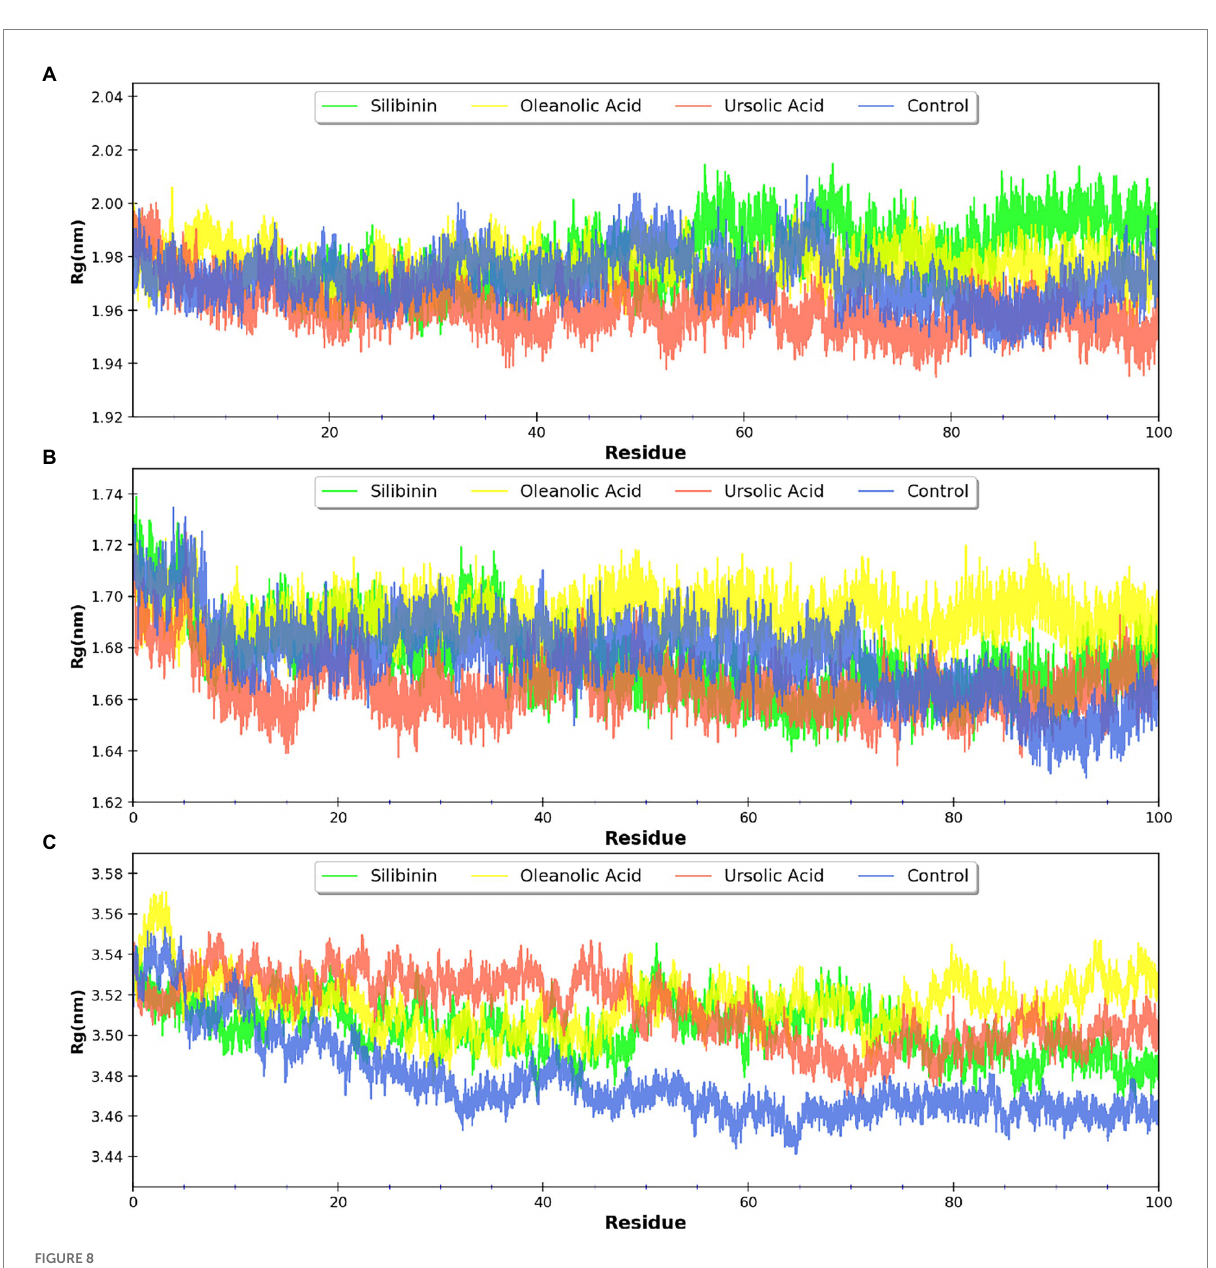
FIGURE 8 Radius of gyration (Rg) for the proteins bound to phytomolecules (A) A26 protein, (B) H3 envelop protein, and (C) D13